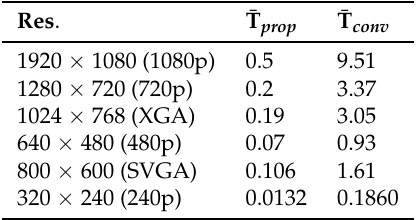
Table 3. Comparison of processing time for fish-eye